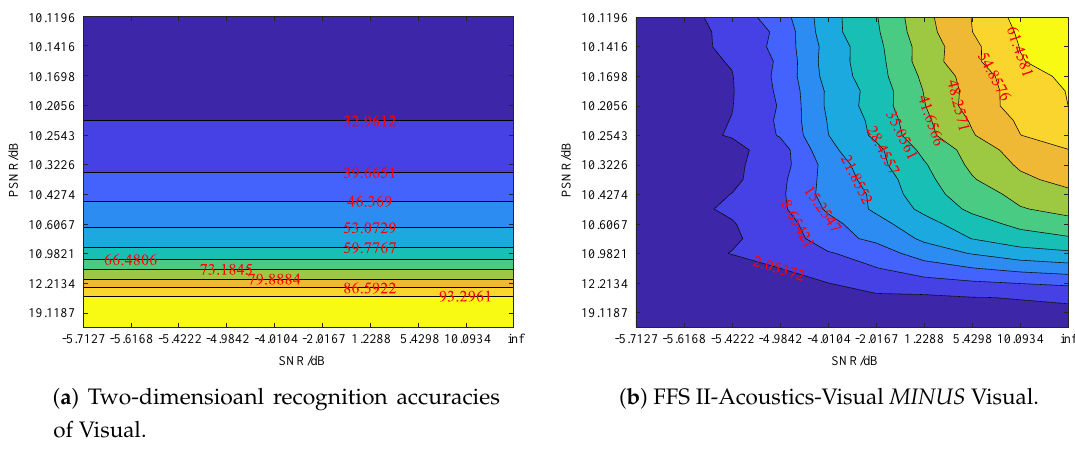
( b ) FFS II-Acoustics-Visual MINUS Visual.